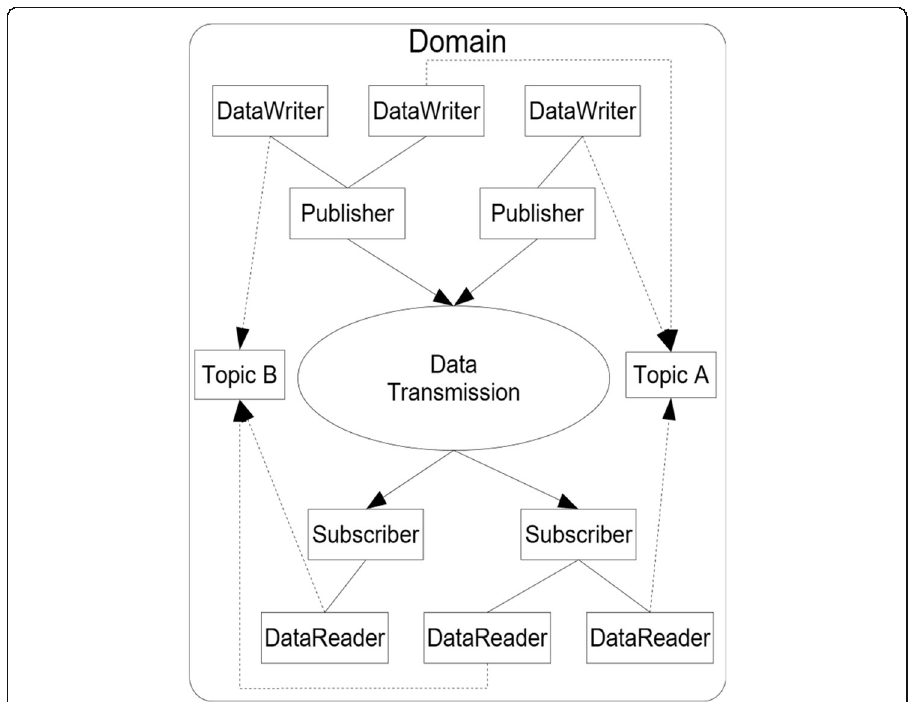
Fig. 1 DCPS conceptual overview (Computing O. Inc. n.d.)